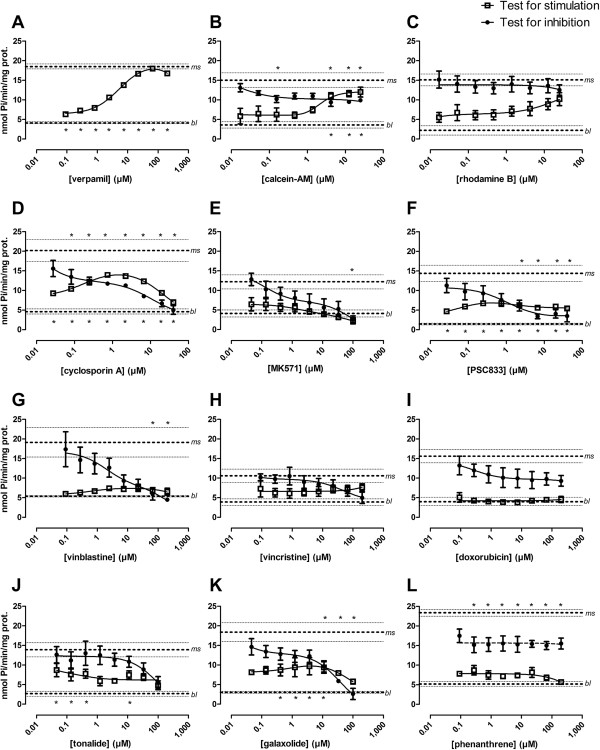
Effects of chemicals on ATPase activities of recombinant zebrafish Abcb4. Compounds were tested for stimulation (open squares) of Abcb4 ATPase and inhibition of the verapamil-stimulated Abcb4 ATPase activities (closed circles). Tested compounds were verapamil (A), calcein-am (B), rhodamine B (C), cyclosporin A (D), MK571 (E), PSC833 (F), vinblastine (G), vincristine (H), doxorubicin (I), tonalide (J), galaxolide (K) and phenanthrene (L). Values are means +/− SEM from three to four independent experiments. Means and SEM ranges of the baseline (bl) and with 40 μM verapamil maximally stimulated ATPase activities (ms) are indicated as horizontal dotted lines. Regression curves for ATPase stimulation were fitted using a modified Michaelis-Menten equation {VS = (K1K2V0 + K2V1S + V2S2)/(K1K2 + K2S + S2) [28,29]}; regression curves for inhibition of the stimulated ATPase activities were fitted to a modified version of this equation describing the descending part of the curve {VS = V1 + ((V2X)/(K2 + X))}. Statistically significant effects on ATPase stimulation or inhibition of stimulated ATPase activities were identified by comparison of data with baseline and maximally stimulated ATPase activities, respectively, using one-way analysis of variance (ANOVA), followed by Dunnett’s test and are indicated by asterisks (*: P <0.05) below the baseline line (different from baseline activity - significant stimulation) or above the line of maximal stimulation (different from the maximally stimulated activity - significant inhibition).